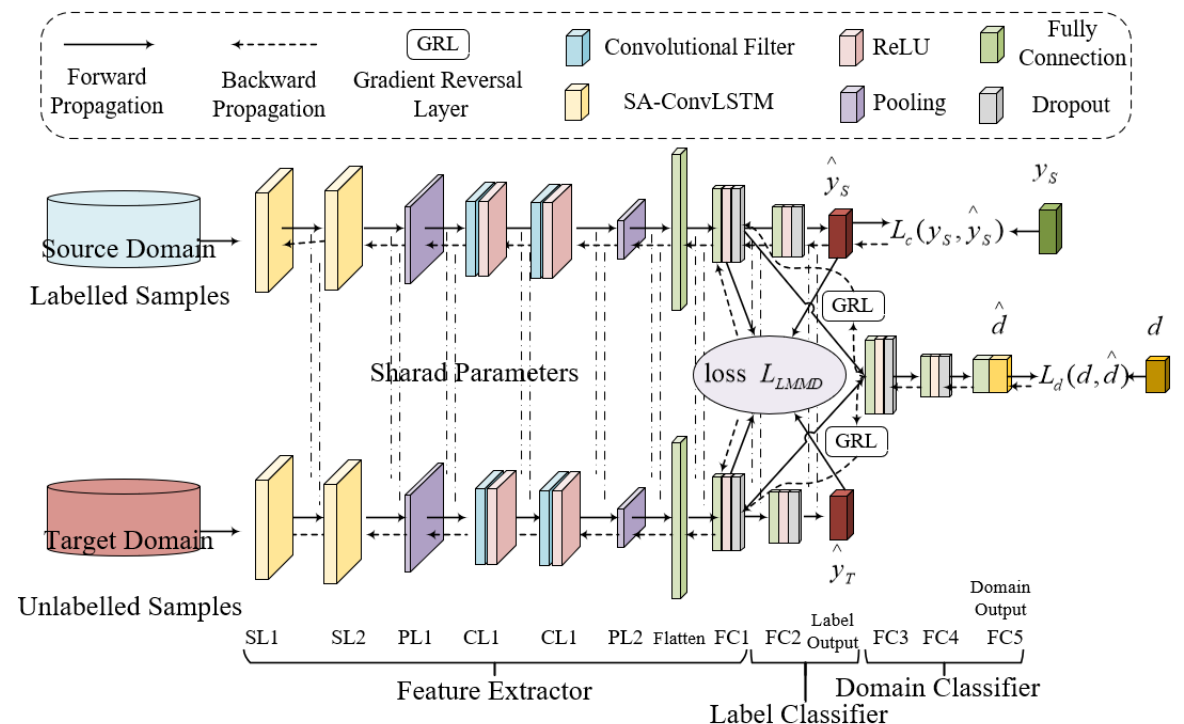
Figure 6. Architecture of the proposed DSTLN, including three modules: feature extractor, label classifier, and domain classifier; and LMMD loss function is used to achieve subdomain transfer learning. Table 1. Architecture and parameter settings for the DSTLN. Modules